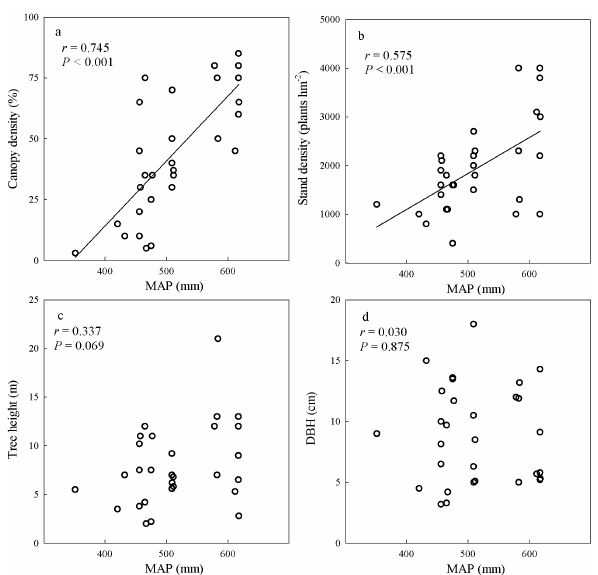
Fig. 2. Plots of canopy density, tree density, tree height and diame- ter at breast height (DBH) variation with respect to the